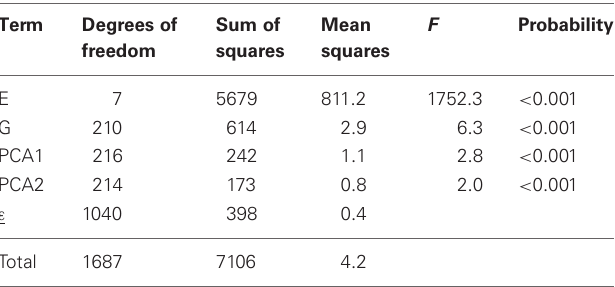
Table 3 | ANOVA table corresponding to application of AMMI2 model (model 4) to CIMMYT maize stress trials.